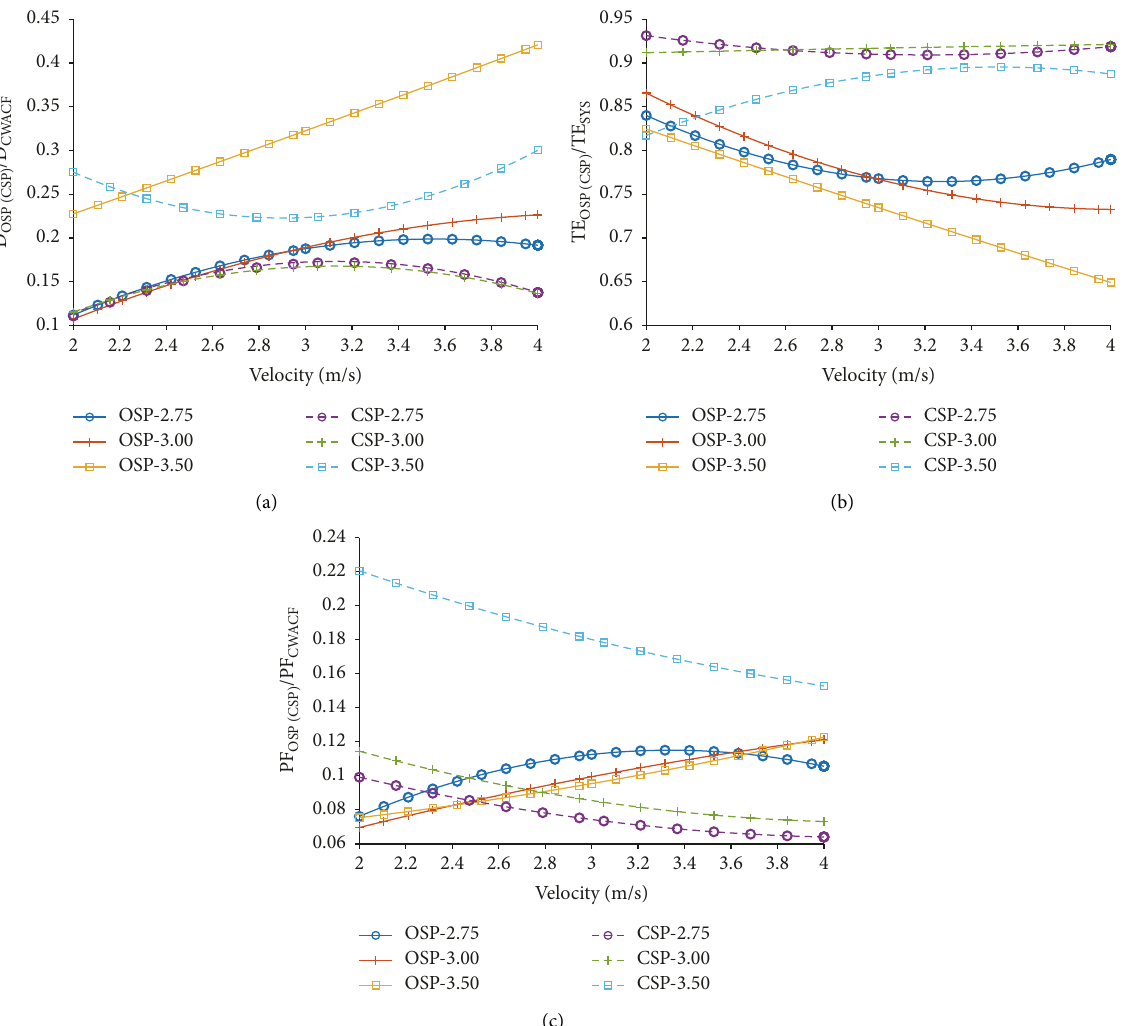
Figure 8: Influence curves of impact velocity. (a) Ratio of lateral displacement peak value at the top of the column. (b) Ratio of total energy peak value of the CSP/OSP specimen. (c) Ratio of lateral impact force peak